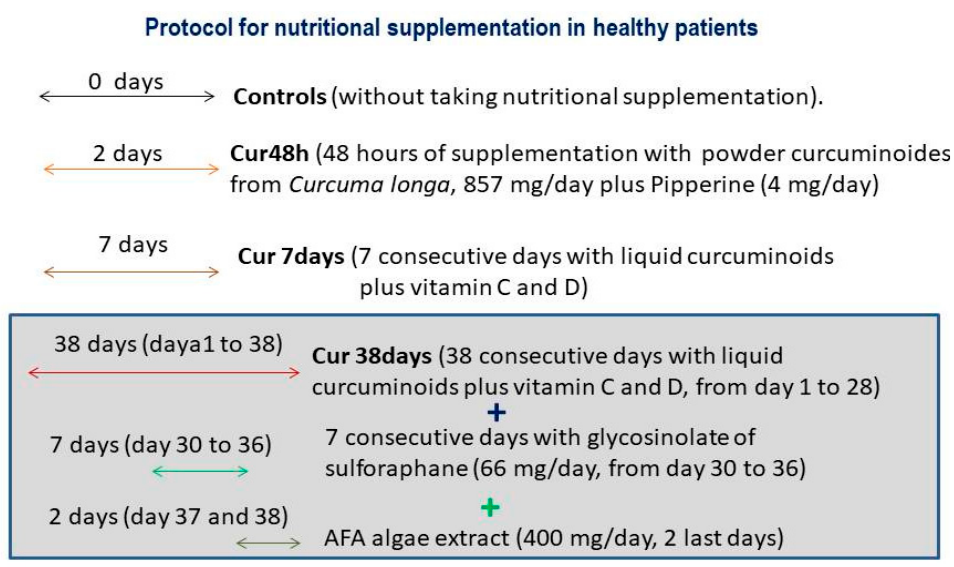
Figure 1. Study Groups.